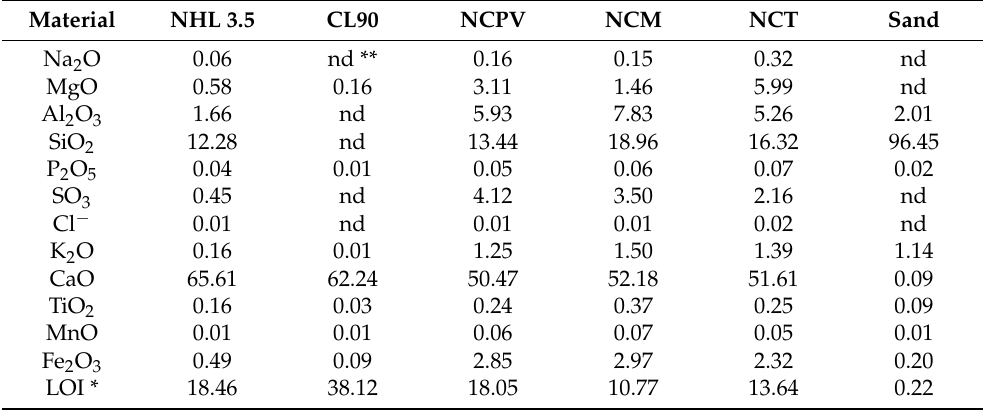
Table 3. Chemical analysis of materials